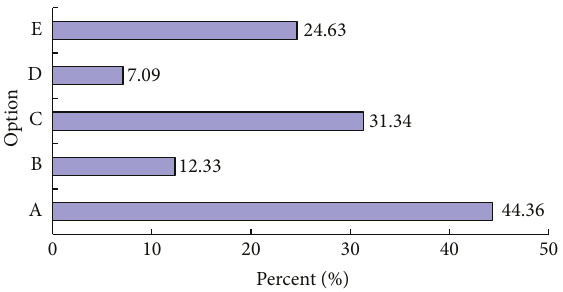
Figure 2: Distribution of reasons for running a red light at countdown signalized